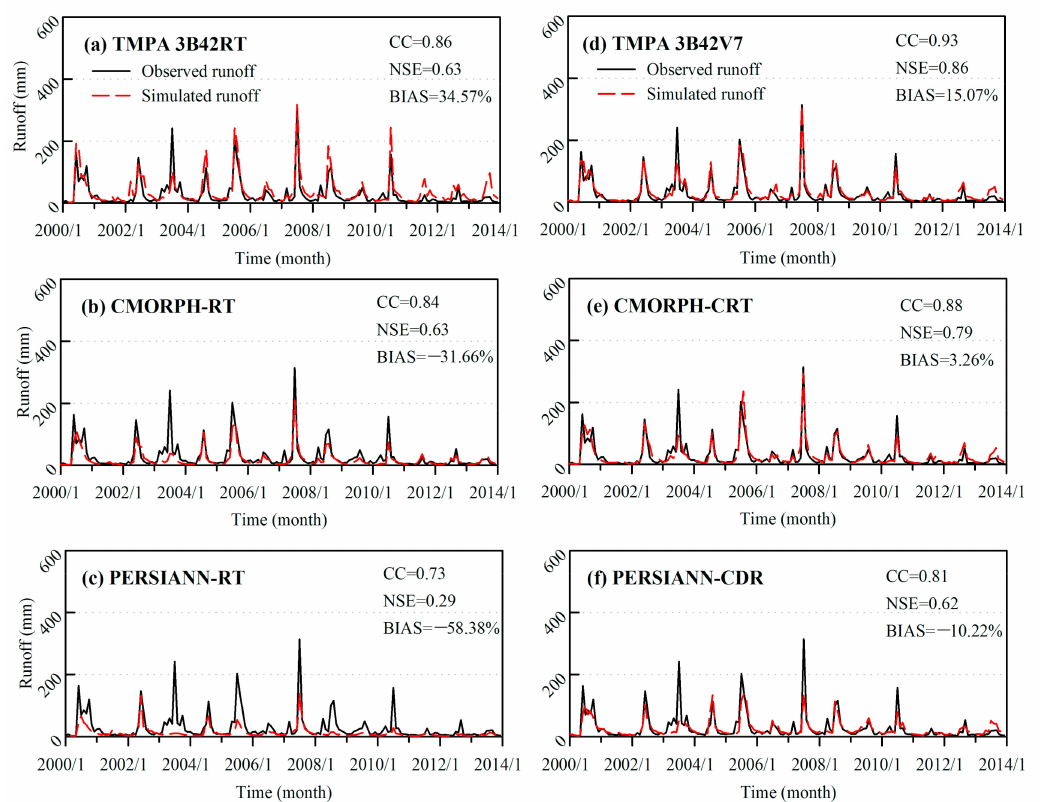
Figure 8. Observed and XAJ model-simulated monthly runoffs from the six SPPs for ( a ) TMPA 3B42RT; ( b ) CMORPH-RT; ( c ) PERSIANN-RT; ( d ) TMPA 3B42V7; ( e ) CMORPH-CRT and ( f )